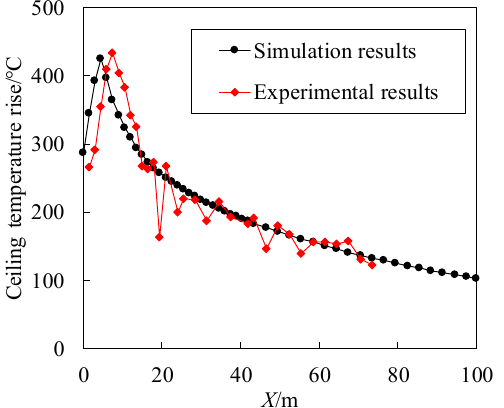
Figure 3. Comparison of ceiling temperature rise by simulation results and experimental results.